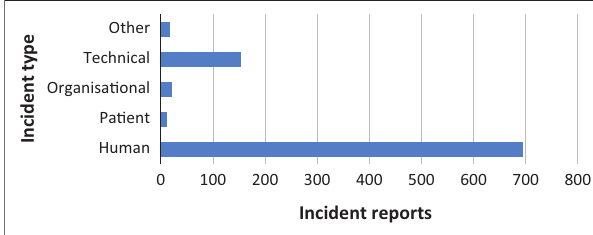
FIGURE 3: Type of incident error.